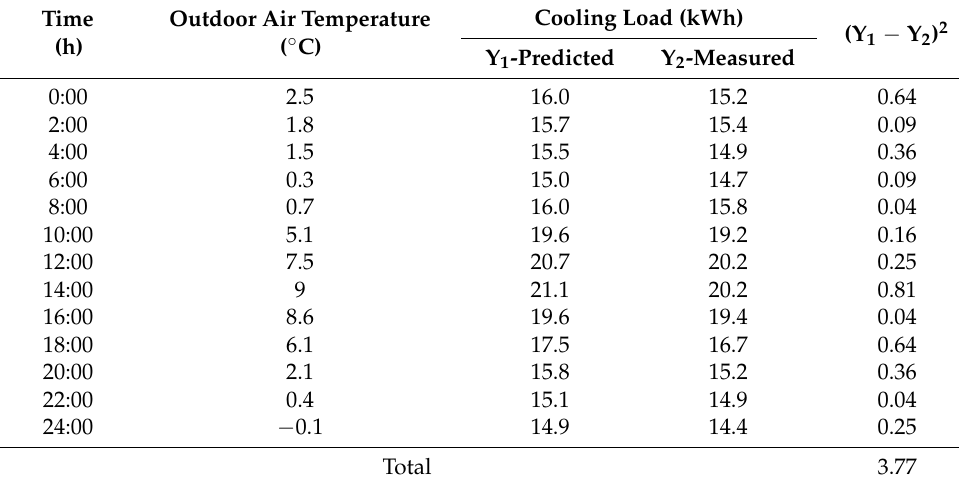
Table 5. Comparison between the predicted and measured cooling loads.